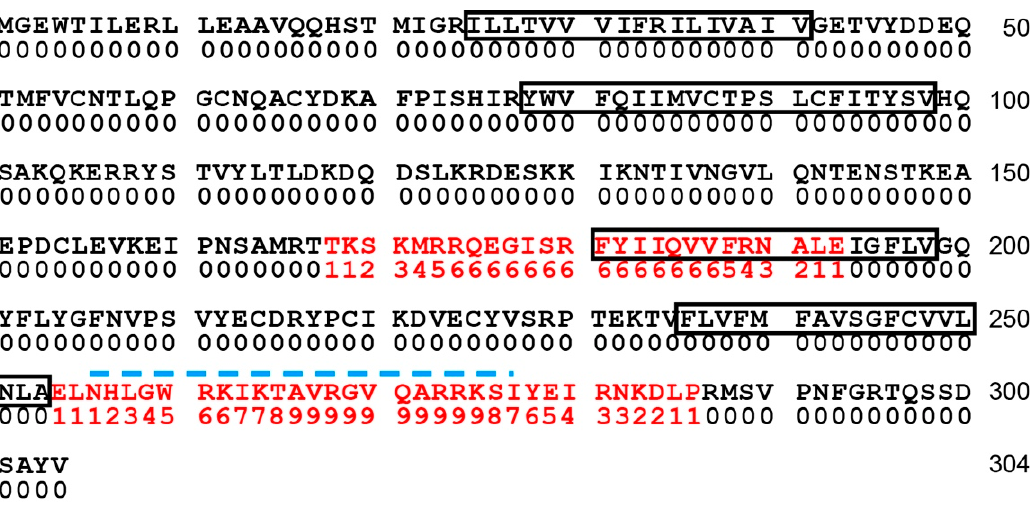
Figure 1. Amino acid sequence of perch Cx35 analyzed for potential calmodulin binding sites via the Calmodulin Target Database [23]. Transmembrane domains are denoted with black outlines and cumulative amino acid sequence numbers are displayed to the right of each line. Putative calmodulin binding sites are highlighted red. The binding site identified by Burr et al. [20] is denoted by the blue dashed line.